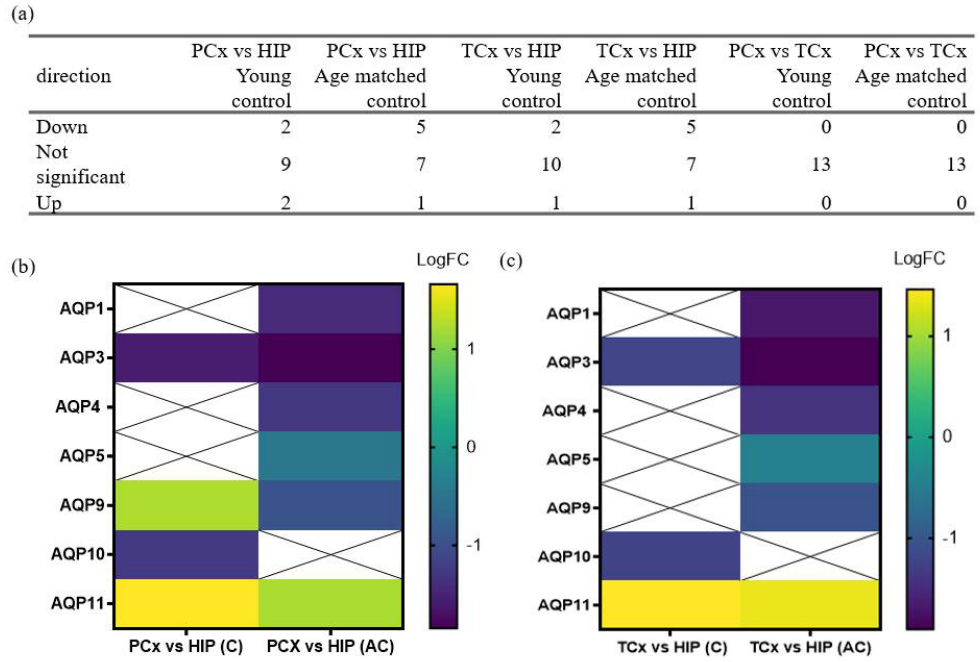
Figure 3. AQP expression profiles differ between non-AD age groups in cortical regions in comparison to the hippocampal formation. ( a ) Summary table of the frequency of occurrence of directions of change in gene expression for non-AD groups (C and AC) in the PCx, TCx and HIP. ( b , c ) Heat maps present the results of differential expression analyses of AQP genes in the ( b ) PCx and ( c ) TCx as compared to HIP in non-AD patients, grouped by age. LogFC represents the log fold change in gene expression in the PCx and TCx compared to the HIP, as detailed in Tables 3 and 4. Squares marked with ‘X’ indicate no significant LogFC change in the respective genes.